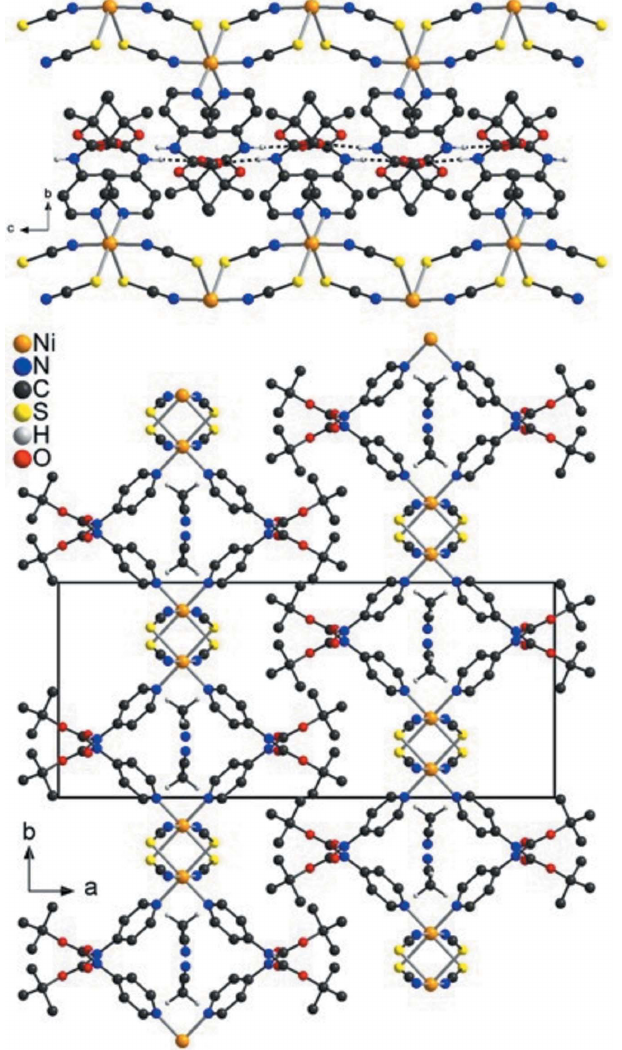
Figure 1 Crystal structure of dithiocyanatobis[4-(boc-amino)pyridine]nickel(II) acetonitrile solvate retrieved from the literature showing a view of the chains with intermolecular N—H (cid:2)(cid:2)(cid:2) O hydrogen bonding indicated by dashed lines (top) and with a view along the crystallographic c -axis